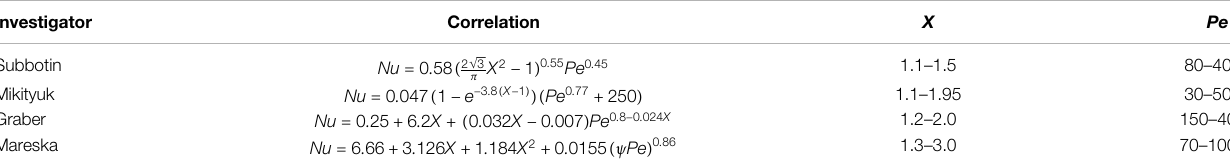
TABLE 6 | Correlations of the Nusselt number for triangular lattices. Investigator Correlation